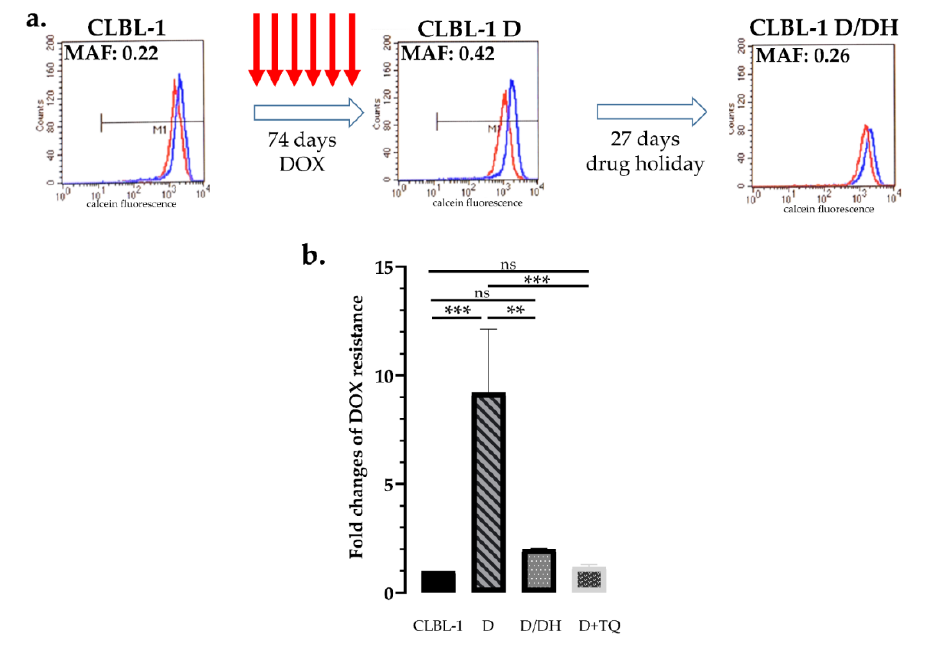
Figure 3. E ff ect of doxorubicin treatment and drug holiday on canine CLBL-1 B-cell lymphoma cells. ( a ) After 6 cycles of DOX treatment (74 days) parental CLBL-1 cells showed a significant increase in P-glycoprotein activity (MAF 0.42 vs. 0.22), which was significantly reduced after a 27-day-long drug holiday (MAF 0.26). Flow cytometry histograms show the results of the calcein assay of cells assayed with (blue) or without (red) the Pgp inhibitor verapamil. ( b ) Changes of doxorubicin sensitivity as a result of drug treatment and drug holiday. Sequential DOX treatments of CLBL-1 cells resulted in a 9.2-fold increase of doxorubicin tolerance, which was significantly reduced following the period of drug holiday. Resistance of CLBL-1 DOX cells was abrogated in the presence of tariquidar (D + TQ). ** p < 0.01; *** p < 0.001; ns: not significant .